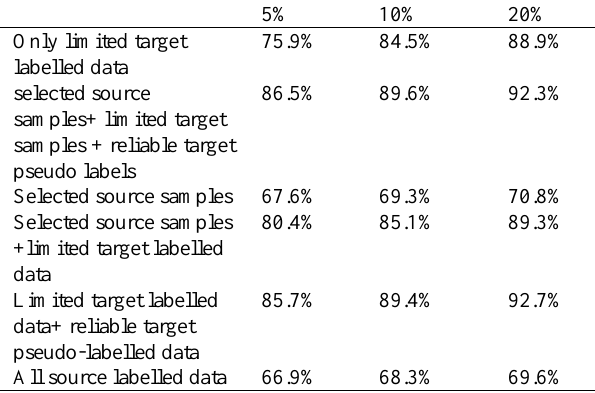
Figure 10. The experimental results of VGG-16 architecture under 5% training ratio.